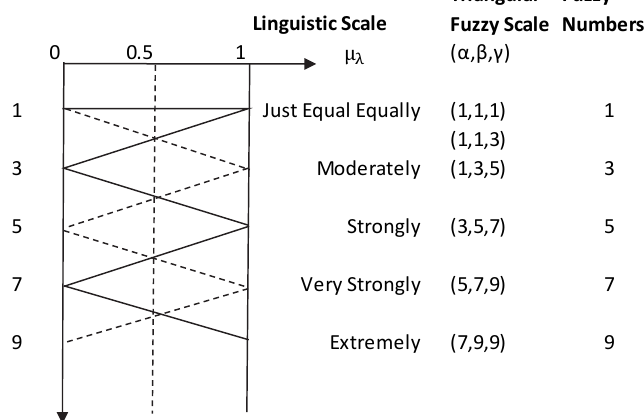
Fig. 1. Linguistic variables for the importance weight of each attribute (Turskis et al.,